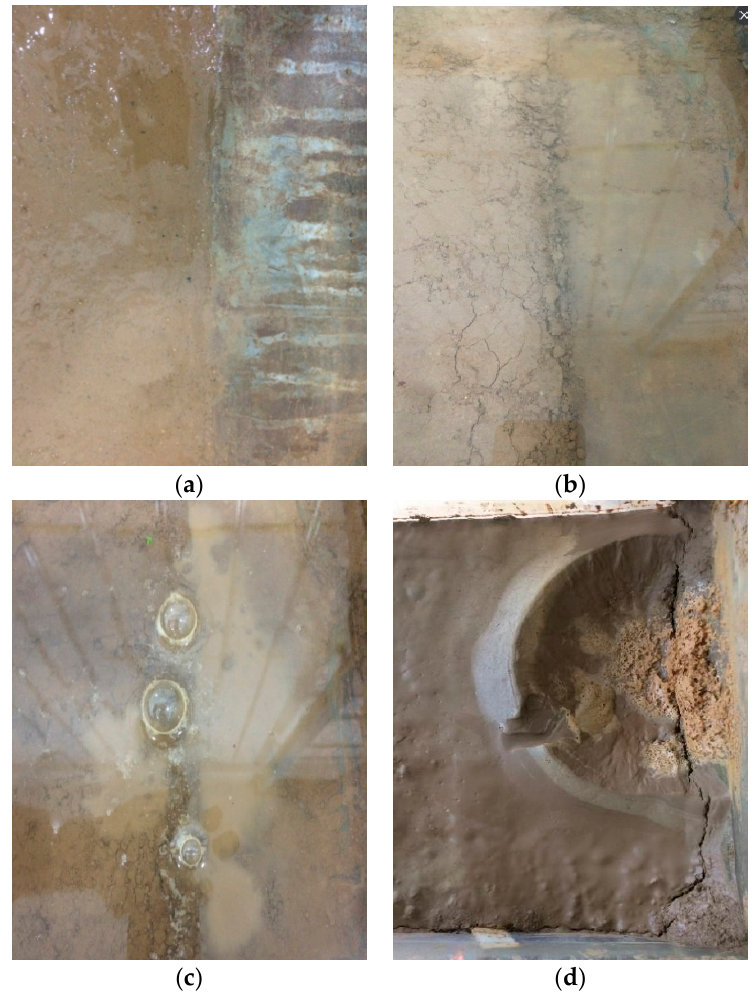
Figure 3. Phenomena of soil–structure-interface internal erosion. ( a ) Stable stage; ( b ) transition stage; ( c ) failure stage; ( d ) interface internal erosion.